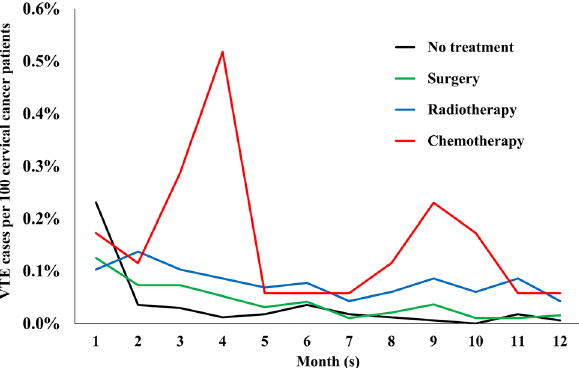
Figure 2. Incidence of VTE for first 12 months after initiation of primary treatment in patients with cervical cancer (HIRA claims data of